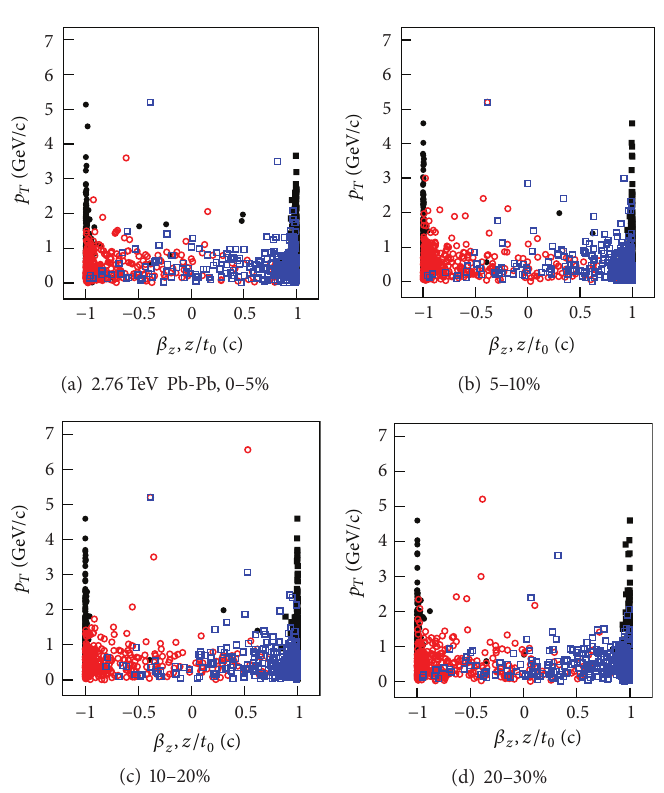
Figure 13: The same as for Figure 4, but showing the results in the space 𝑝 𝑇 − 𝛽 𝑧 (or 𝑝 𝑇 − 𝑧/𝑡 0 ).